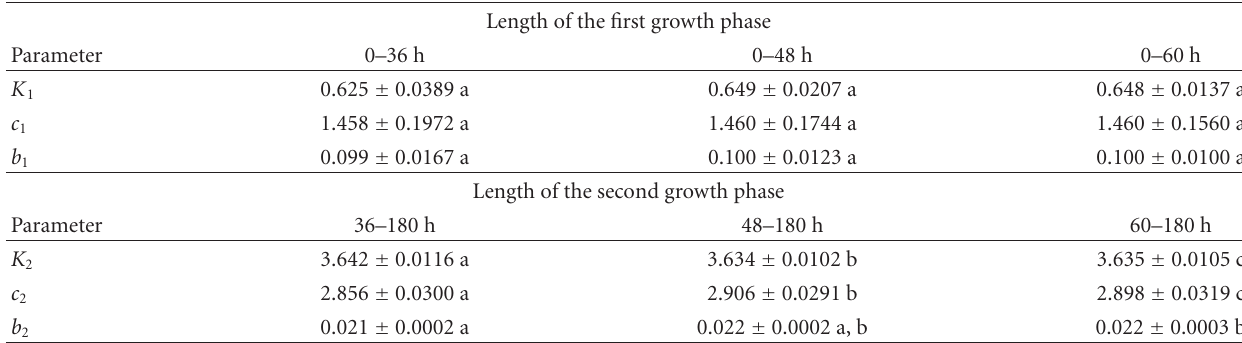
Table 2: Parameter values (means ± SD) of the Logistic equations (A.1) and (A.2) obtained by considering di ff erent time intervals for the first and second growth phases in the second realkalized fed-batch culture of Ent. faecium CECT 410 in